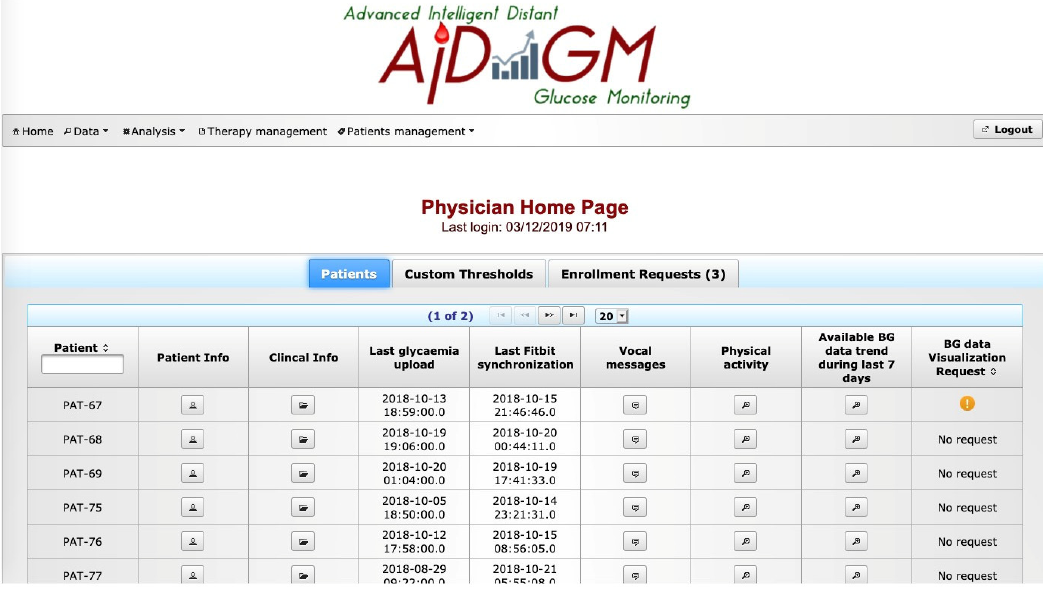
Figure 4. Physician’s home page.